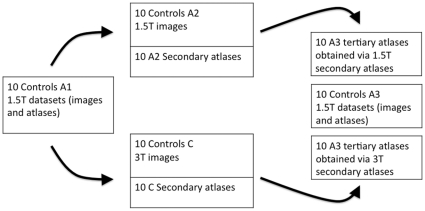
The flowchart of the experiments on assessing the potential bias resulting from the difference in field strength between atlas images and segmentation targets.A1, A2 and A3: groups of ten subjects from the 30 atlas datasets scanned at 1.5T. group C: ten randomly selected 3T images from the control set. Middle column top row: A1 datasets were used to anatomically segment A2 images with MAPER, resulting in automatically labeled images (A2secondary). These secondary atlas datasets were then used to segment the A3 images with MAPER. Middle column bottom row: A1 datasets used to segment group C with MAPER. The resulting ten secondarily labeled group C datasets were then used to anatomically segment the A3 images with MAPER. Last column: three sets of anatomical segmentations for A3 images: two automatically generated either via 1.5T or 3T secondary atlases, and one manual gold standard segmentation.